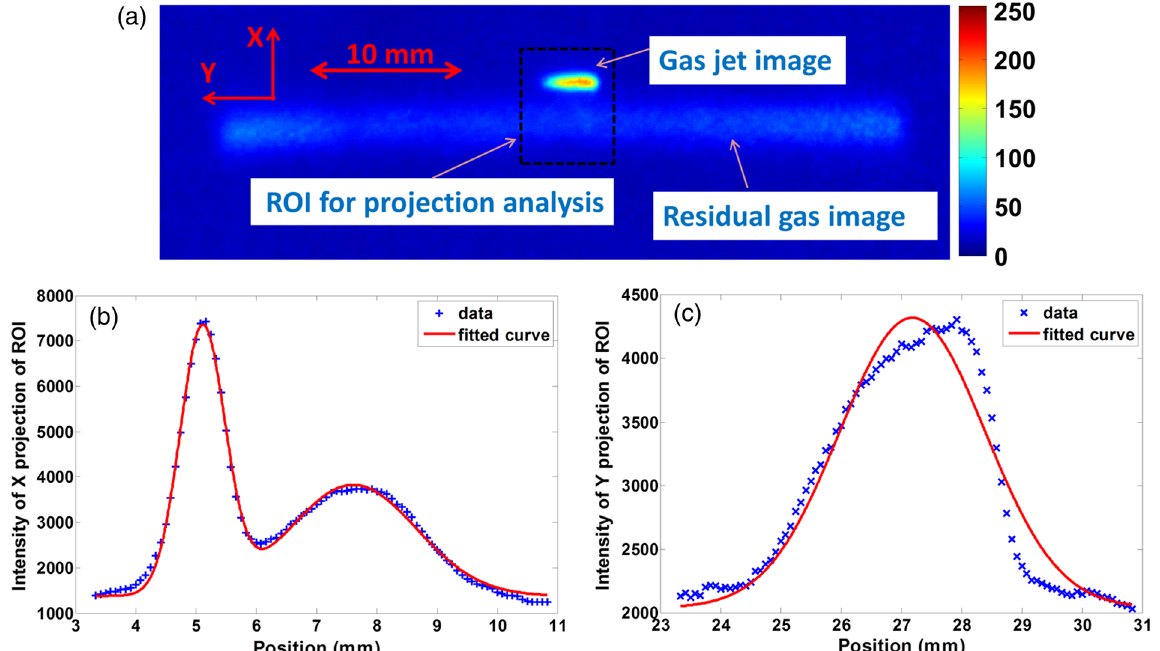
FIG. 16. (a) Images of electron beam measured from both the gas jet (larger size third skimmer) and residual gas; projected profiles in (b) x direction and (c) y direction (electron beam energy is 3.75 keV, external collecting E-field is 7 . 5 kV = m, the gas pulse duration time is 1 s and the exposure time of the camera is 70